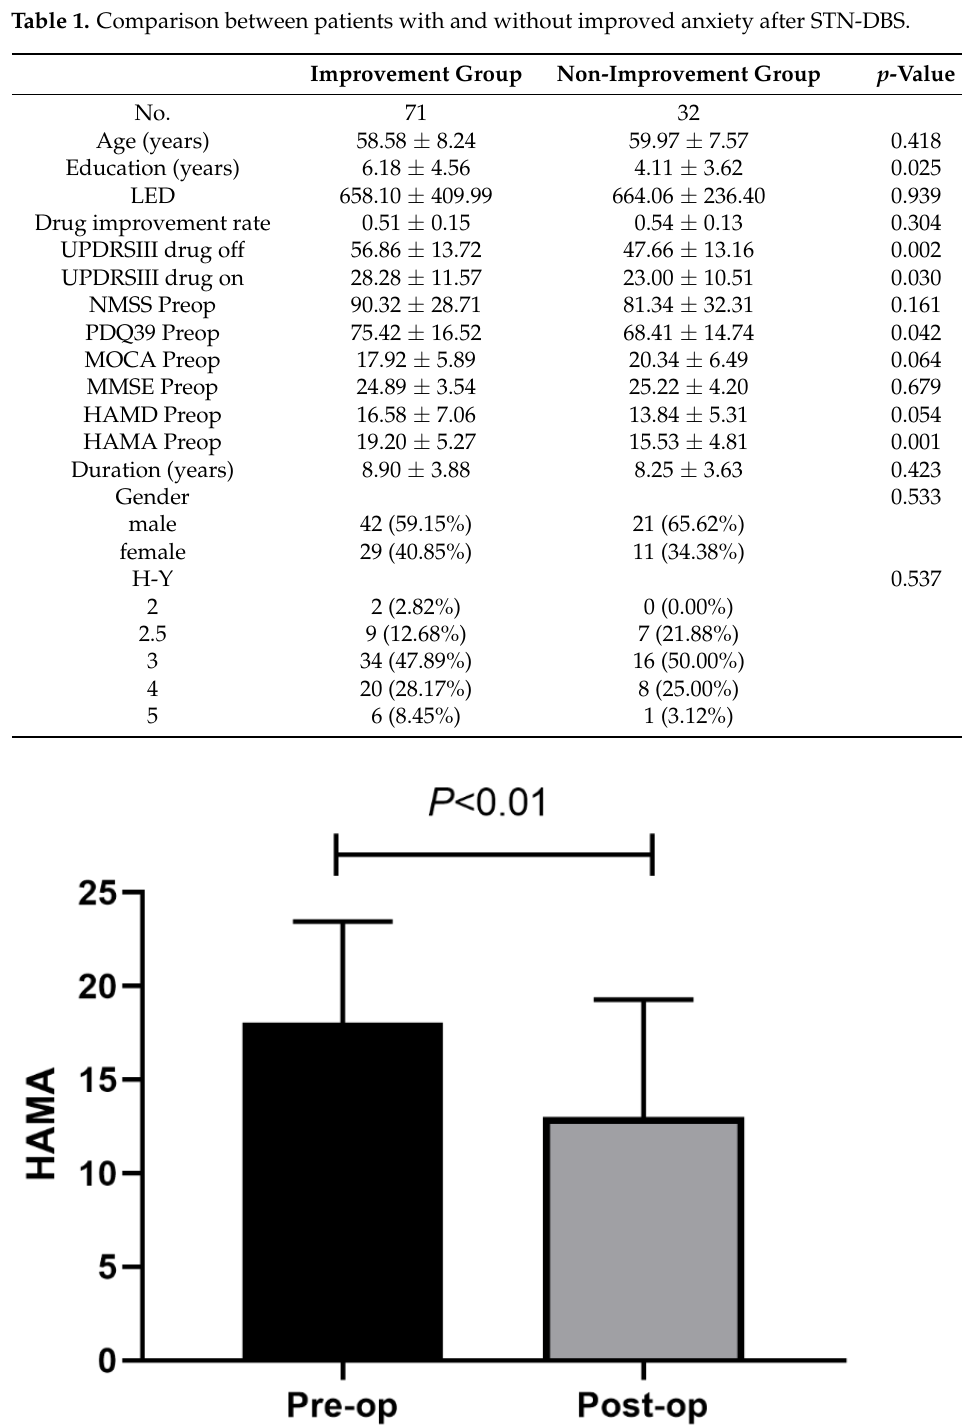
Figure 1. Comparison of HAMA score between pre-operation and 1 year after the operation. The improvement group included 42 males (59.15%) and 29 females (40.85%), and the average age was 58.58 years. In contrast, the non-improvement group included 21 males (65.62%) and 11 females (34.38%), and the average age was 59.97 years. Education years, HAMA Preop, PDQ-39 Preop, UPDRS-III drug-on and UPDRS-III drug-off scores were